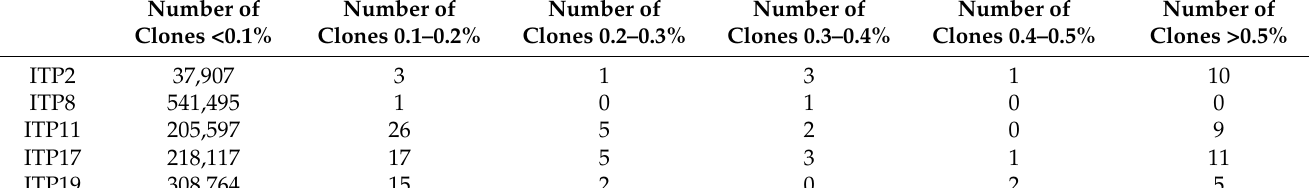
Table 3. The distribution of CD4 + T cell repertoire in peripheral blood before treatment.